Question: How would you classify this visualization?
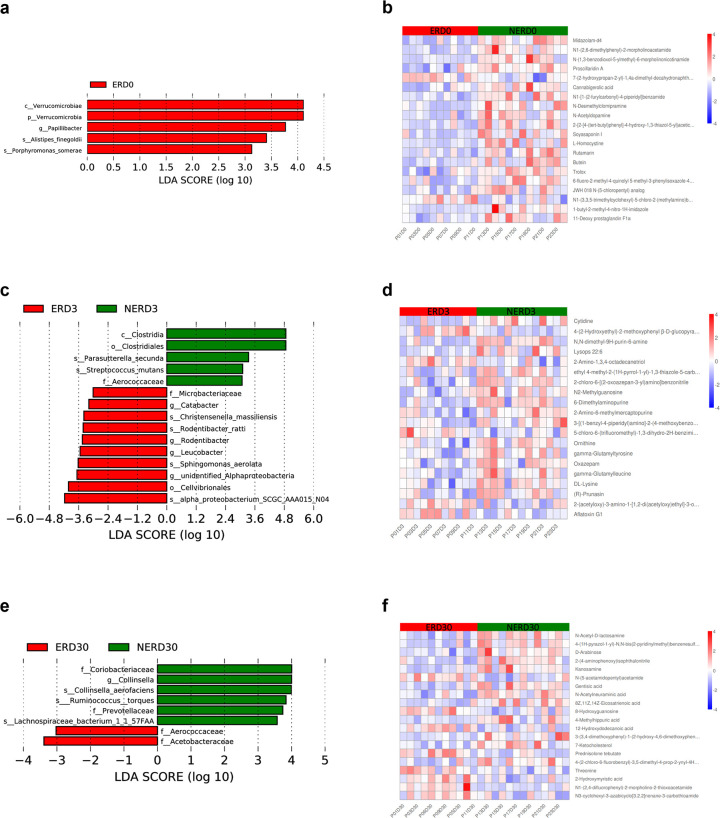
Answer: heatmap